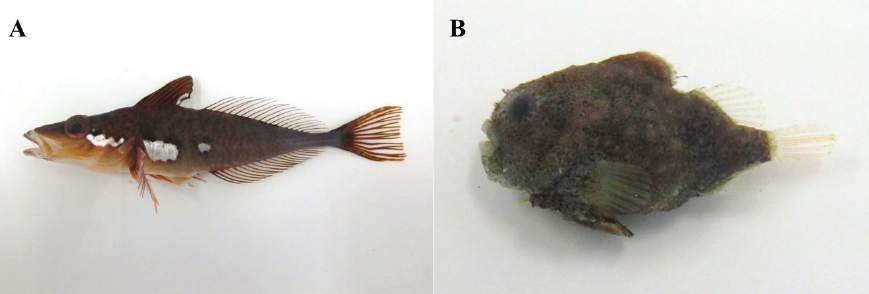
Figure 4. A Pseublennius percoides , MFD-671, 47.8 mm SL B Pseudoblennius marmoratus , MFD-927, 19.3 mm